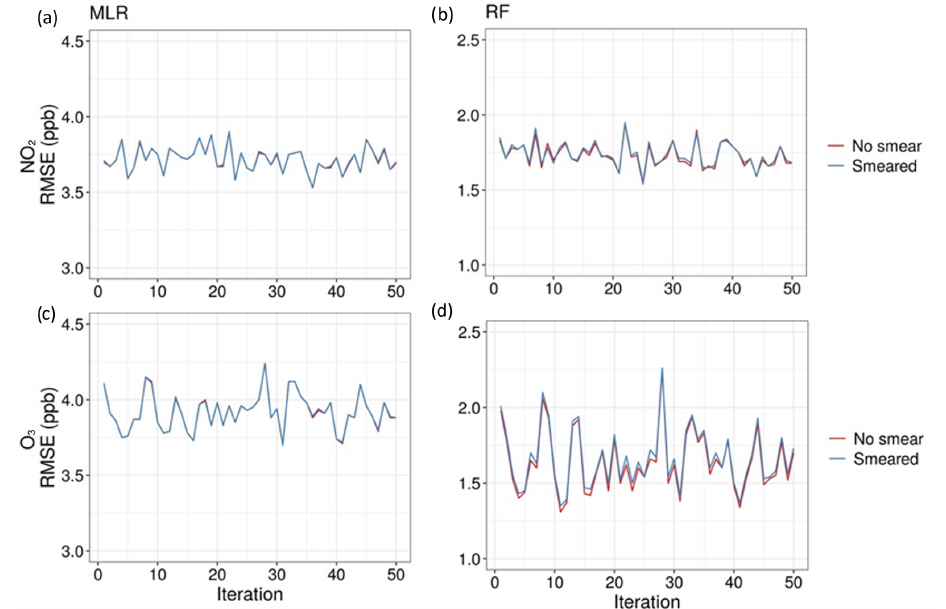
Figure 12. RMSE of models trained using smeared reference measurements versus actual reference measurements for (a) NO 2 with MLR,